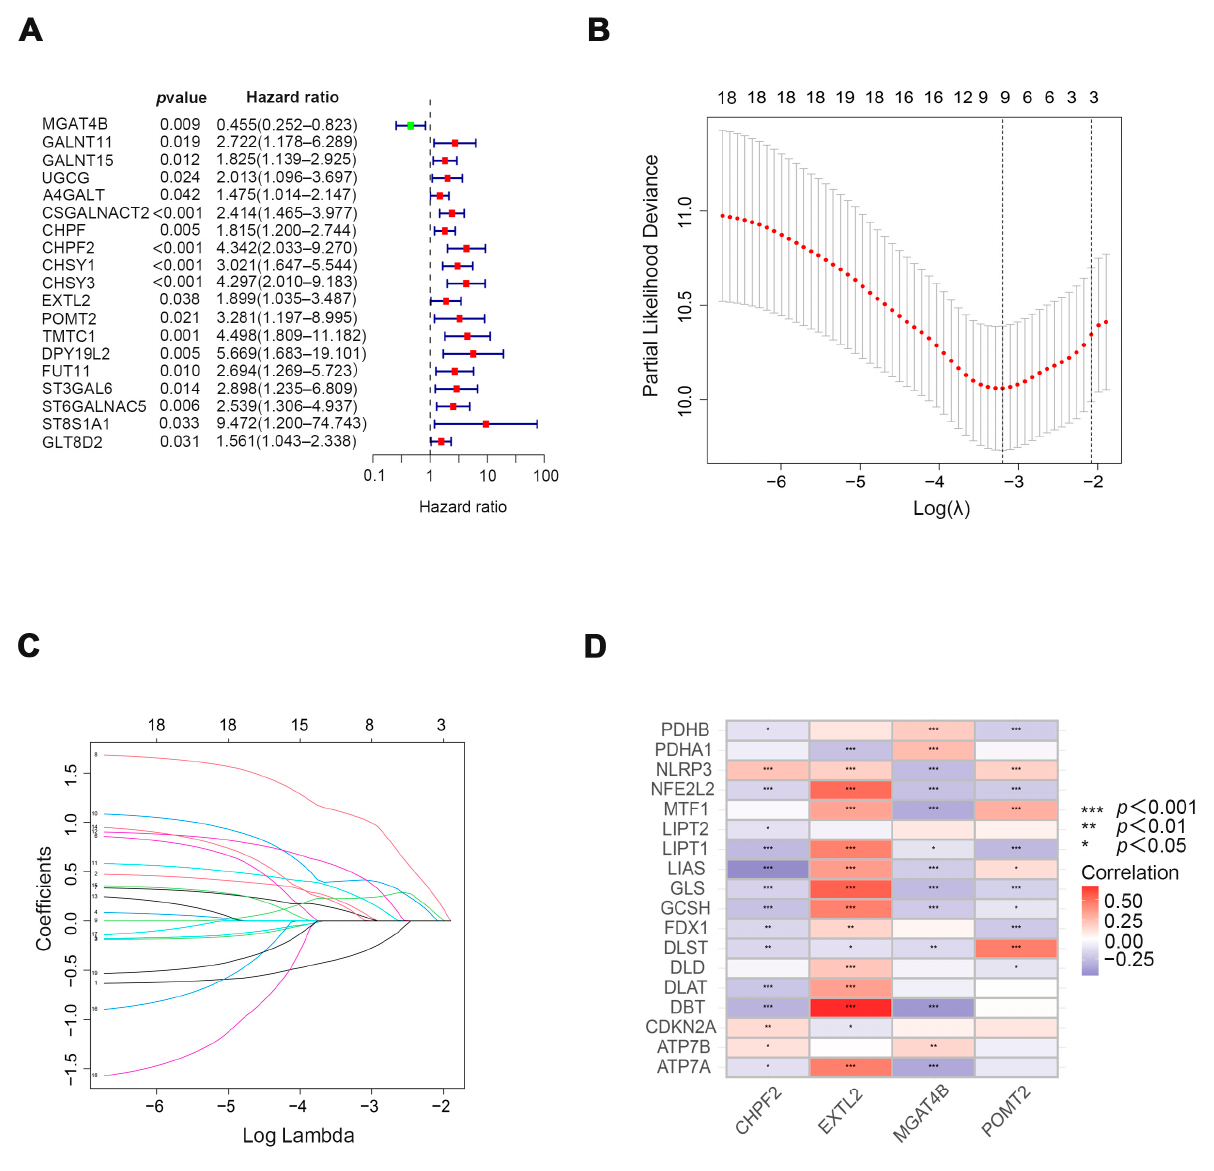
Figure 2. Four prognostically significant cuproptosis-related glycosyltransferases were obtained. ( A ) Nineteen glycosyltransferases with prognostic significance were identified by univariate COX analysis. ( B ) Using the minimum criterion method, the confidence intervals for each are shown and dotted with the best value source. ( C ) Partial likelihood deviance in the case of different numbers of variables. The horizontal axis represents the log value of the independent variable lambda, and the vertical axis represents the coefficient of the independent variable. ( D ) A heatmap depicts the relationship between four glycosyltransferases and the cuproptosis-related genes. * p < 0.05, ** p < 0.01, *** p < 0.001.